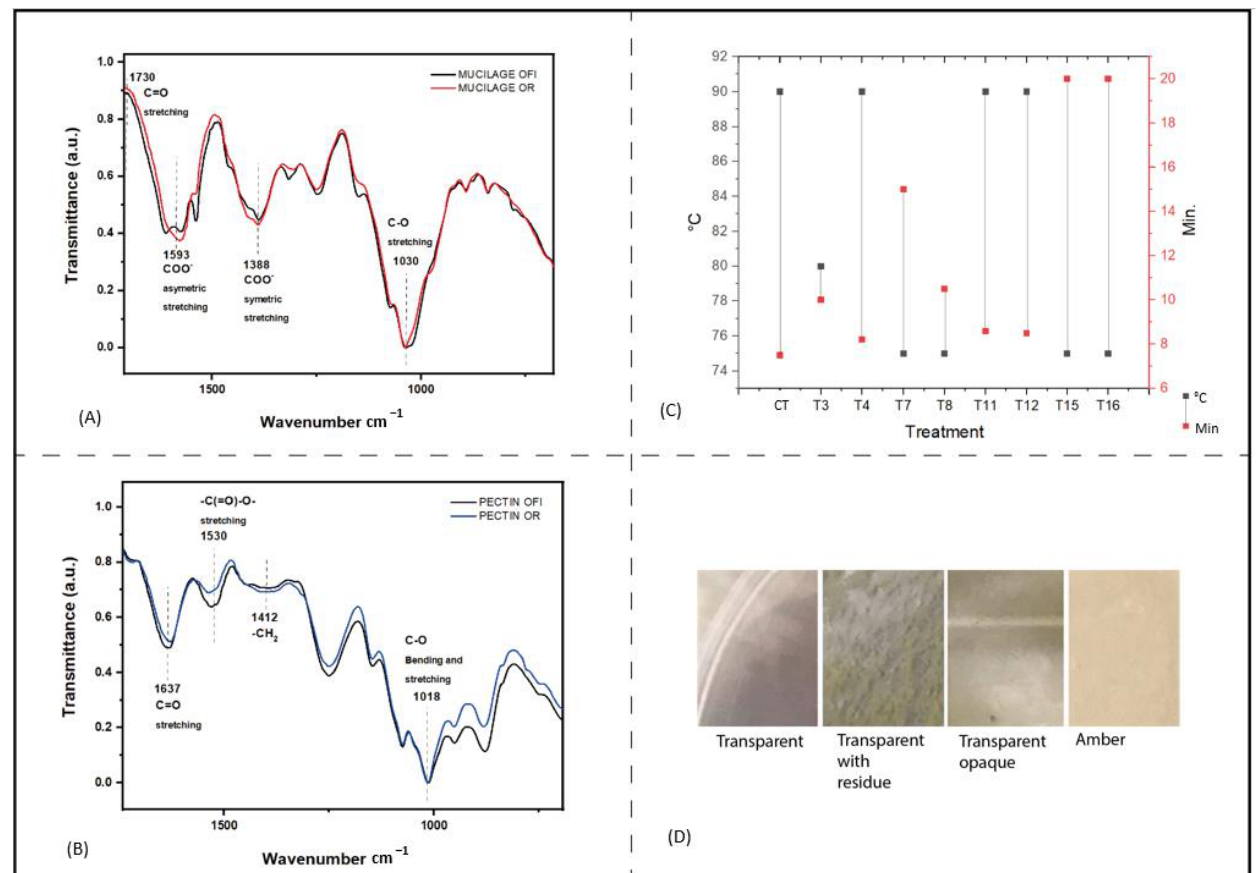
Figure 1. Chemical composition of hydrocolloids and agar substitute stability obtained from O. ficus-indica and O. robusta. ( A ) FTIR spectra of mucilage obtained from O. ficus-indica and O. robusta ( B ) FTIR spectra of pectin obtained from O. ficus-indica and O. robusta . ( C ) Temperature and minutes to the gel of designed formulates. CT control treatment. ( D ) Photographs of plates with agar gels with different colors. A catalog of colors was made with experimentation with Opuntia hydrocolloids (pectin and mucilage).